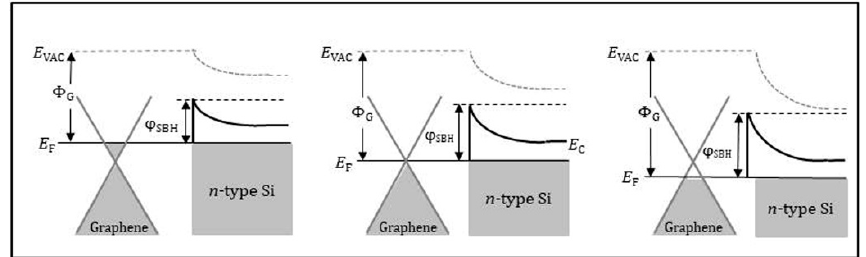
Figure 4. Schematic energy band diagram of the graphene/ n -type Si interface for the pristine graphene state ( middle ), the graphene exposed to electron-donor gas ( left ) and the graphene exposed to electron-acceptor gas ( right ). E VAC , E C , Φ G , E F , and ψ SBH indicate the vacuum energy, conduction band, graphene work function, Fermi level, and Schottky barrier height, respectively. Reproduced from (Hye-Young Kim, [55]), Copyright 2013, American Chemical Society.